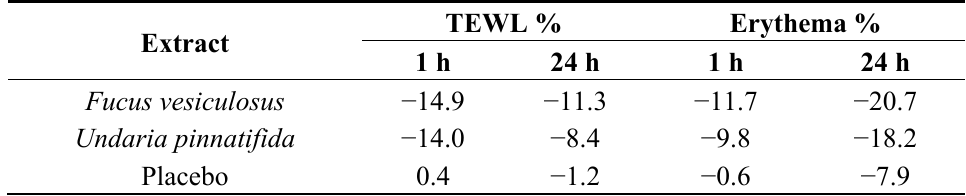
Table 12. Erythema and TEWL Study Scheme 3, as compared to control ( n = 25) (percent change of mean vs. control).